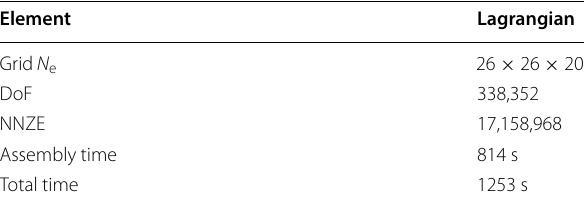
Table 5 Time and memory used in MoVFEM with the anisotropic